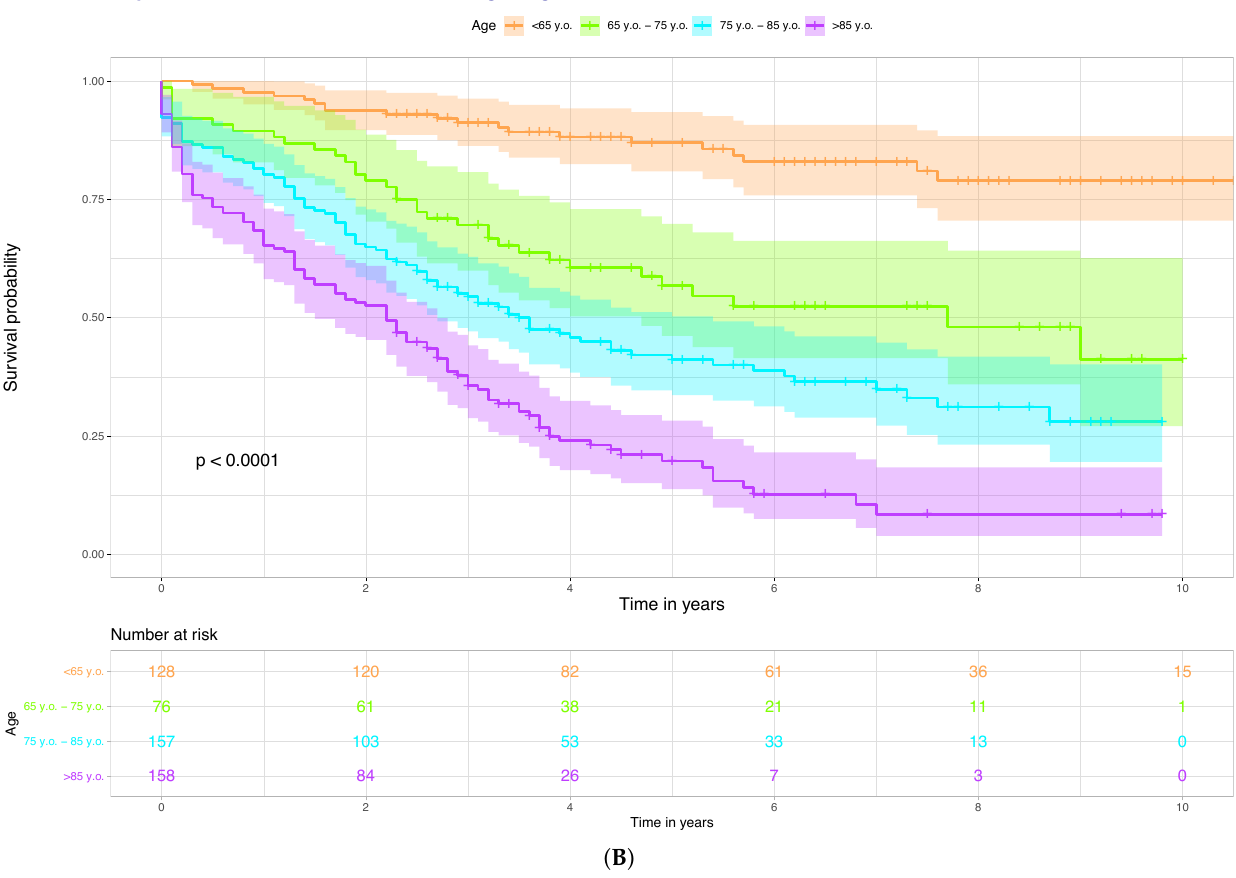
Figure 8. ( a ) Position and ( b ) orientation RMSE box-and-whiskers for EKF, SEKF and SEKF 2 , respectively. Figure 1. Kaplan–Meier survival curves (one-year mortality) according to ( A ) gender and ( B ) age of patients. It is now quantitatively evident how the smoother (either SEKF or SEKF 2 ) ensures a Table 1. Statistically significant unadjusted associations with one-year lower error for the trajectory estimates. As reported in Figure 6, being the SEKF 2 unfeasible in real-time but yielding de facto the same uncertainties of SEKF, the rest of the results report the latter only.